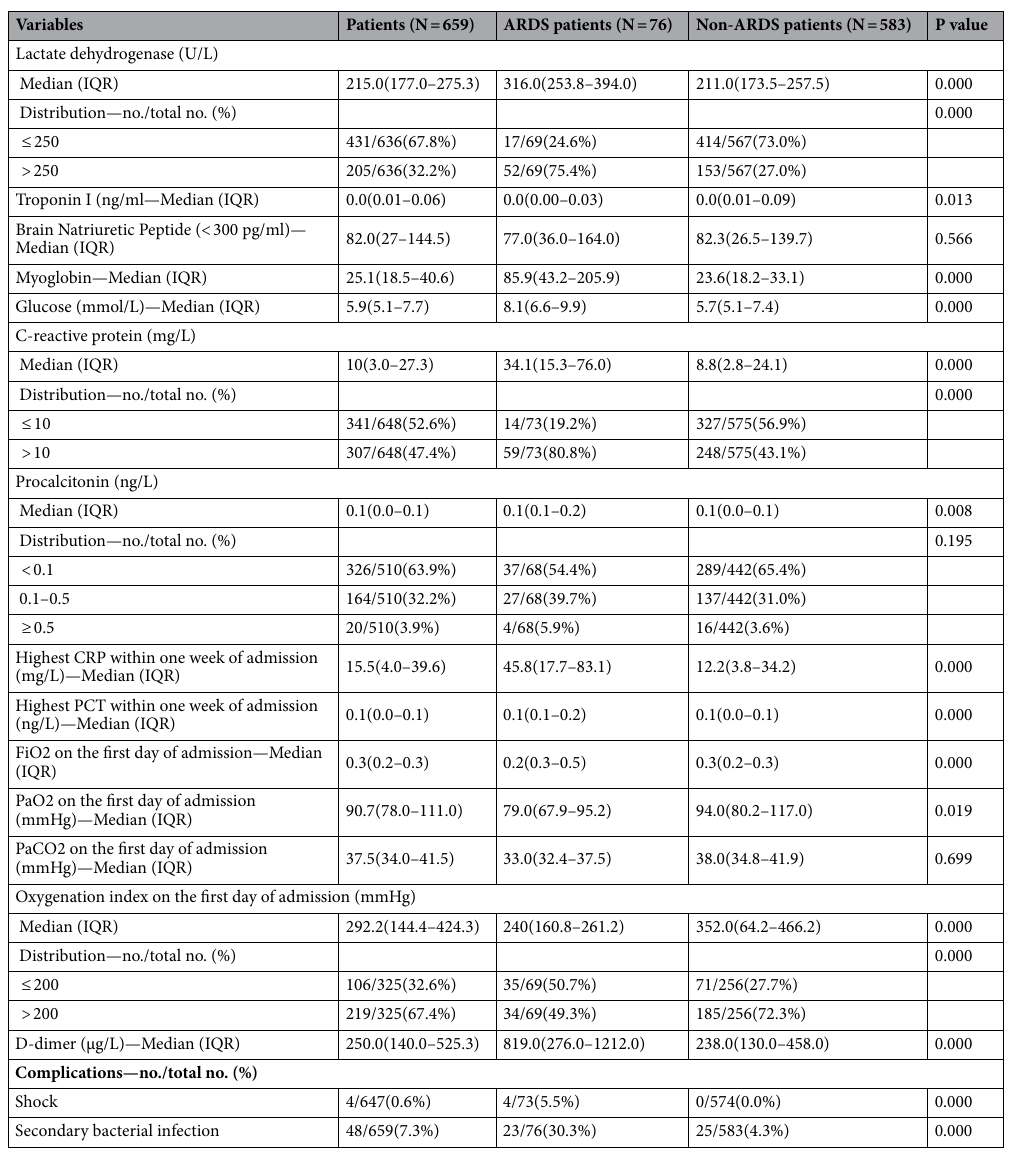
Table 3. Radiologic, laboratory findings and complications. CT, computerized tomography; CRP, c-reactive protein; PCT, procalcitonin; no., number. Data are presented as medians (interquartile ranges, IQR) and no./ total no.